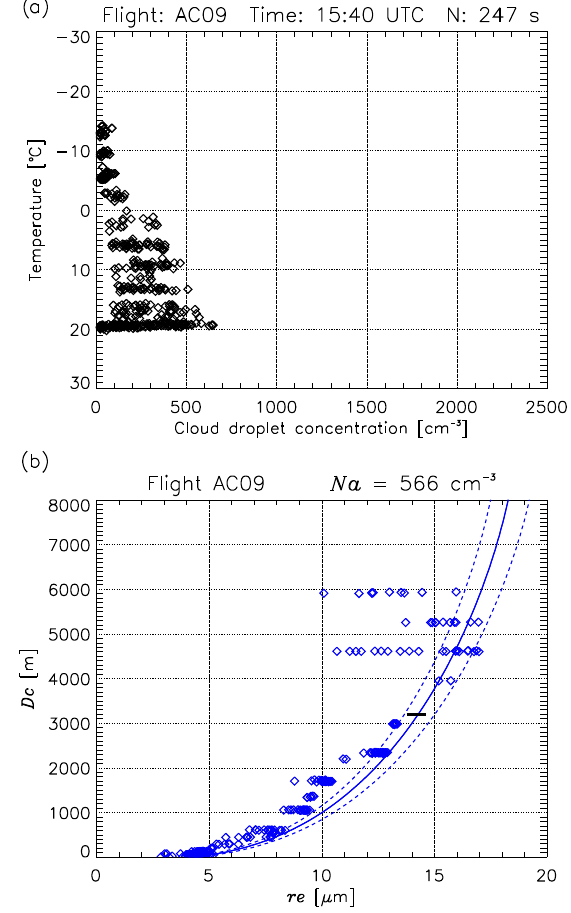
Figure 11. (a) Cloud droplet concentrations measured with the CCP–CDP as a function of temperature for flight AC09. Each dot indicates 1Hz average concentration. The sample number in sec- onds ( N ) and the start time of the cloud profile are shown at the top of the panel; (b) similar to Fig. 9 for flight